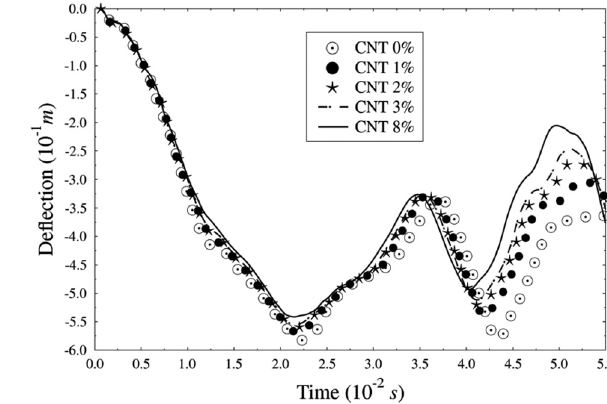
Figure 10: Linear dynamic time histories of CNTFPC cylindrical panels for di ff erent R/a ratios.